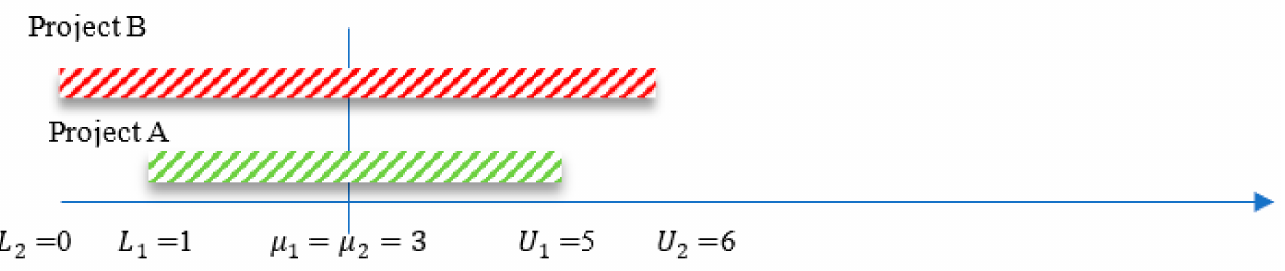
Figure 13. When µ i is equal for two alternatives, the alternative with lower σ i is